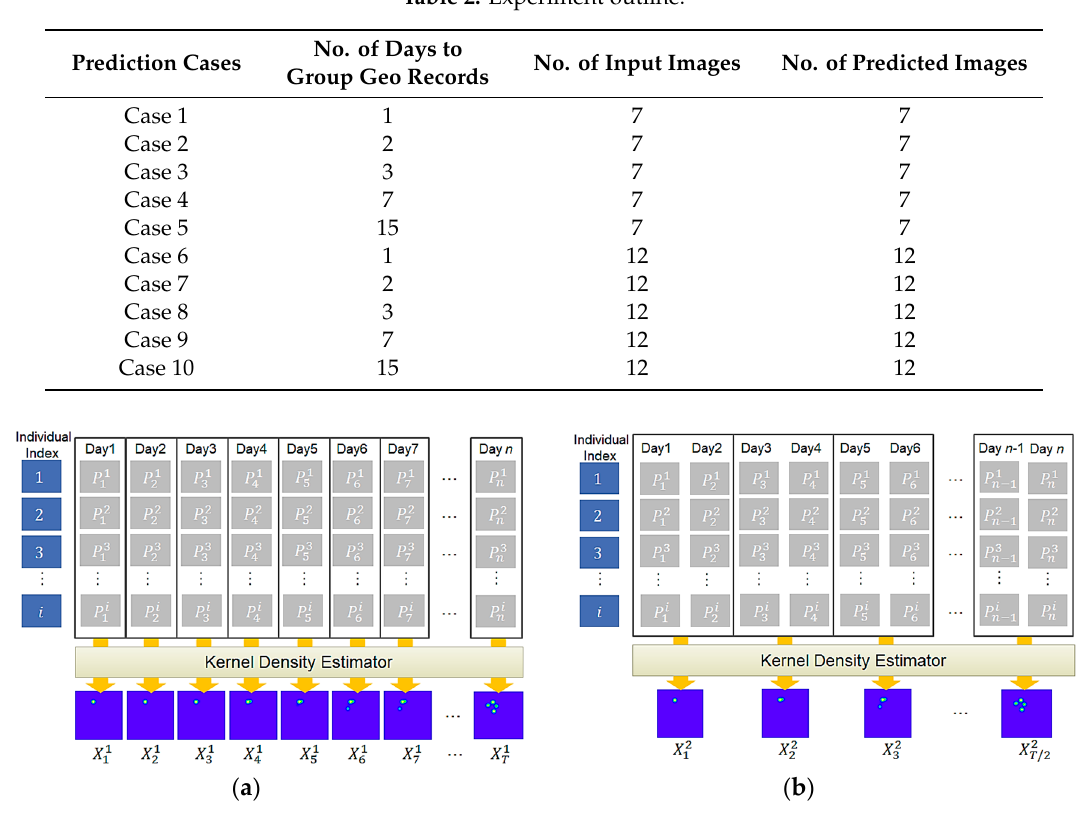
Table 2. Experiment outline.